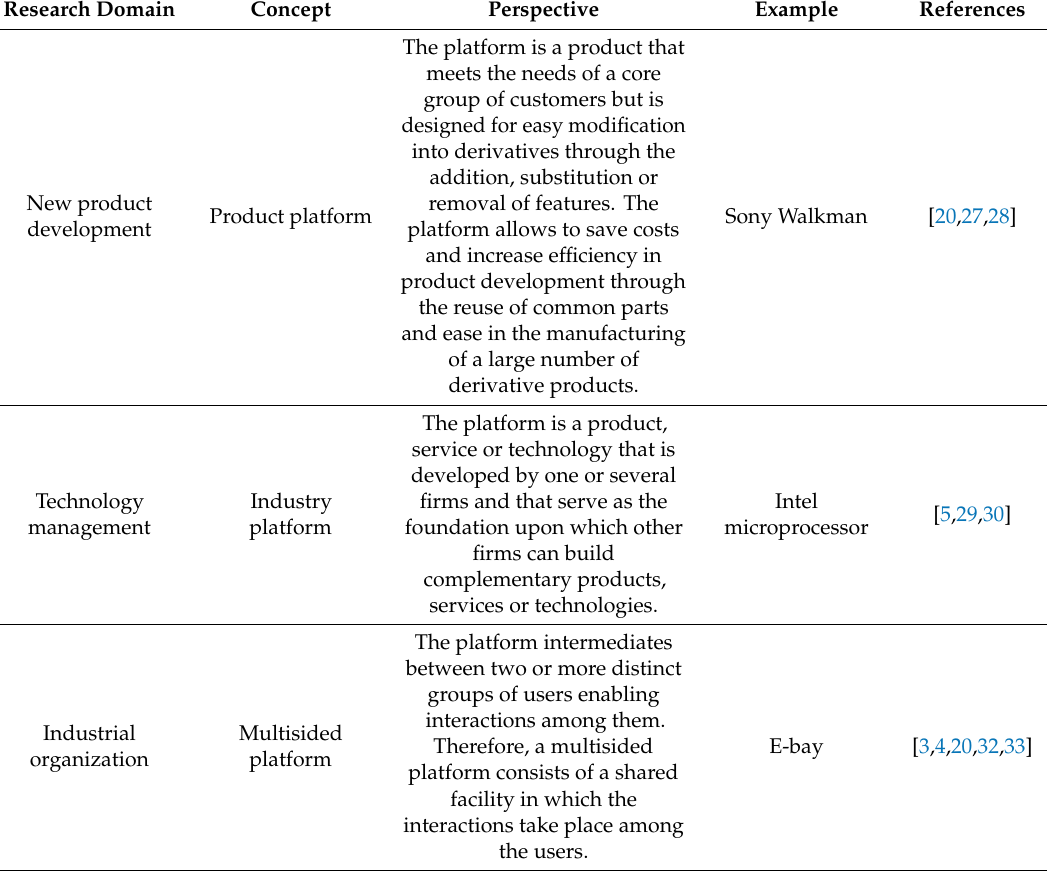
Table 1. The platform concept in di ff erent research